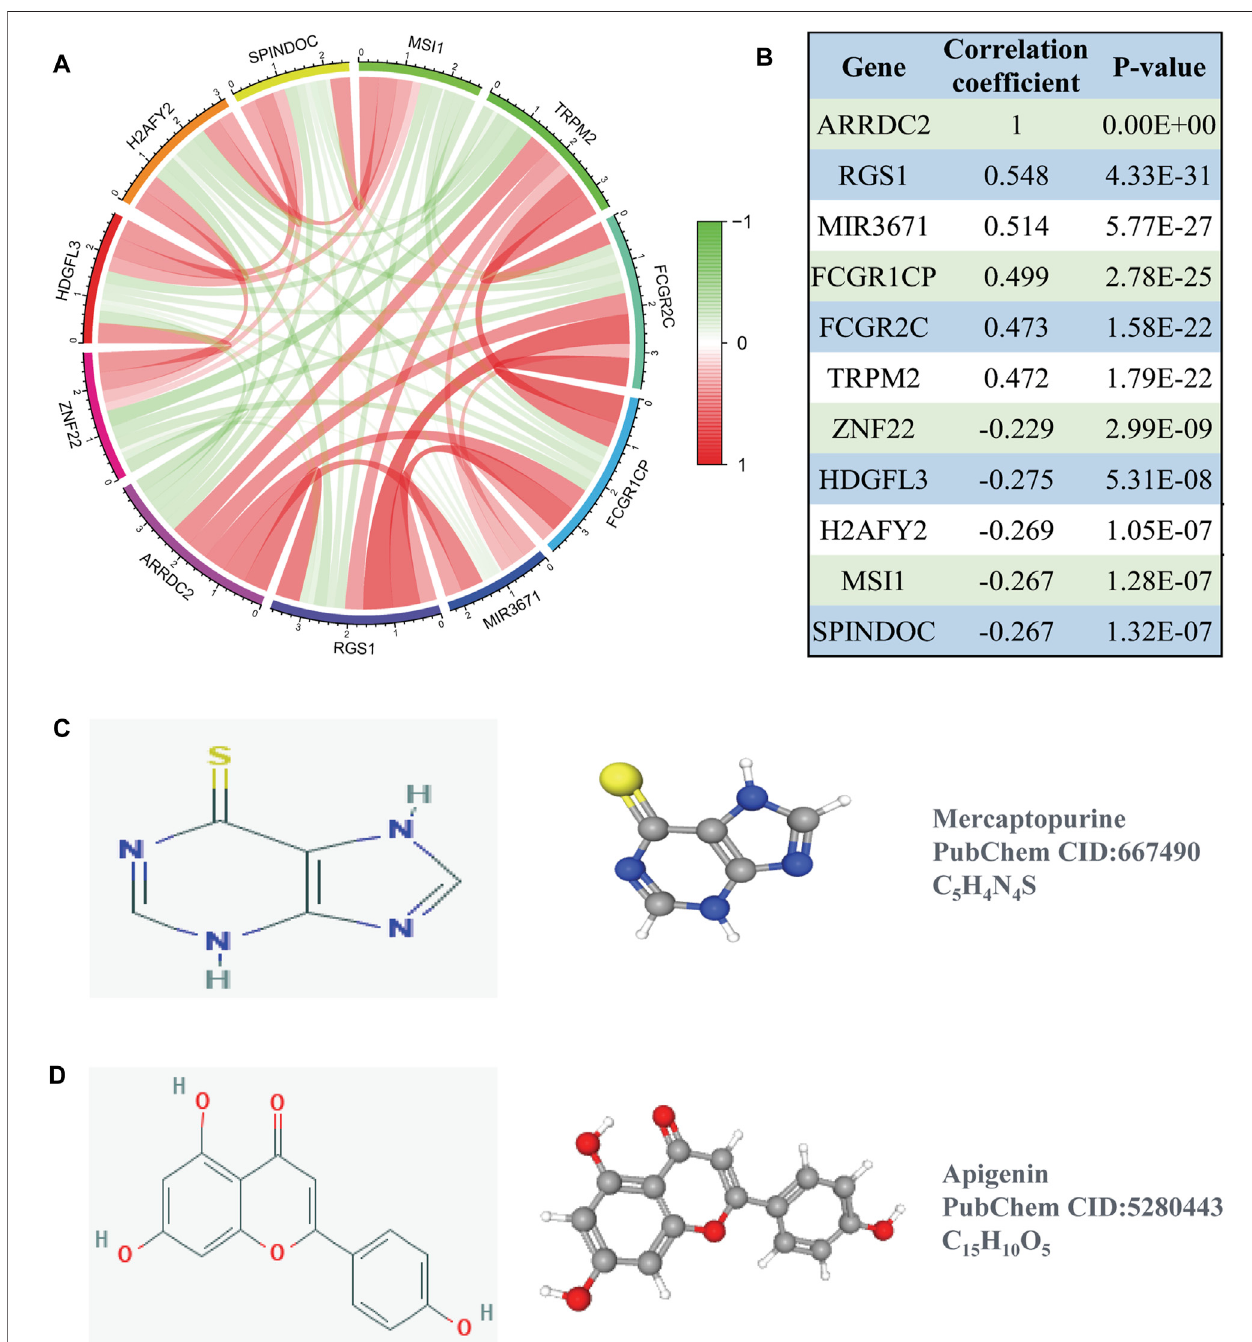
FIGURE 7 | Co-expression analysis of ARRDC2. (A) The ten most signi fi cant genes of positive and negative correlating with ARRDC2. (B) The Correlation coef fi cients and p values ofthe ten mostsigni fi cantgenes ofpositive and negativecorrelatingwithARRDC2. (C,D) Screening ofgene therapy drugs for ARRDC2 based on the CMap and Pubchem database (Drug name, chemical structure, 2D structure and 3D structure). (C) Mercaptopurine. (D) Apigenin.